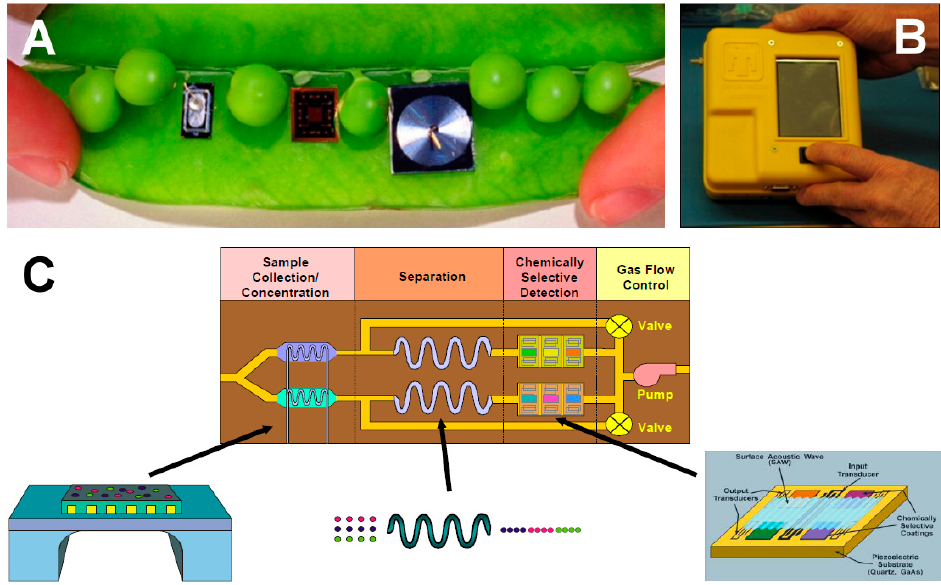
Figure 21. MicroChemLab. ( A ) Principal components of the μ GC system fit easily inside a snow-pea pod: (left to right) surface acoustic wave (SAW) detector, μ PC, and μ GC; ( B ) Packaged MicroChemLab; ( C ) Schematic of the components.